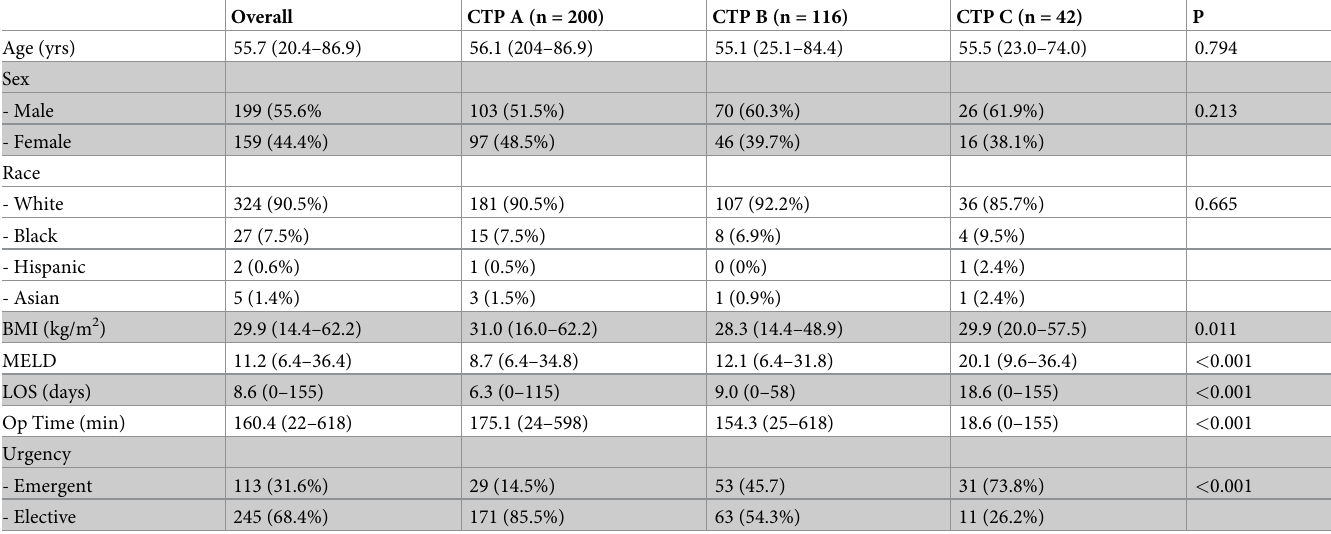
Table 1. Patient demographics (N = 358).